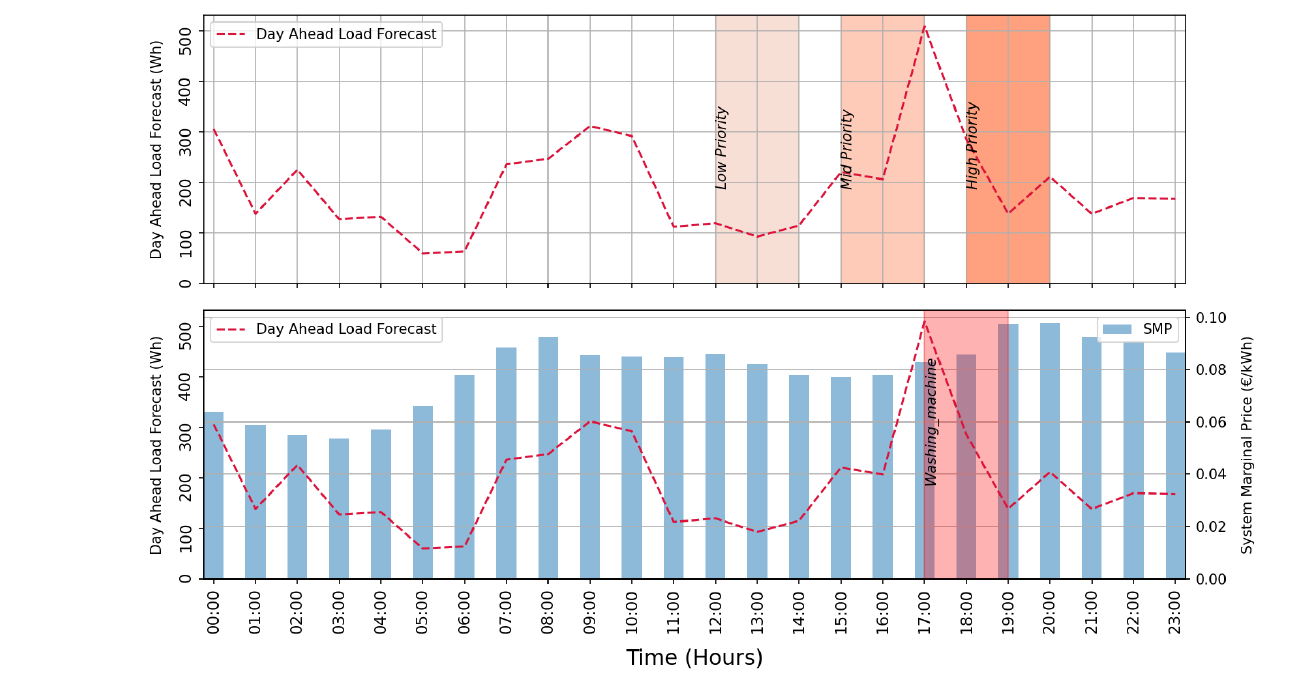
Figure 10. User preferences, day-ahead load forecast and SMP used to produce the optimal appliance scheduling for one household (house ID: User 1, experiment day: 1 June 2021).